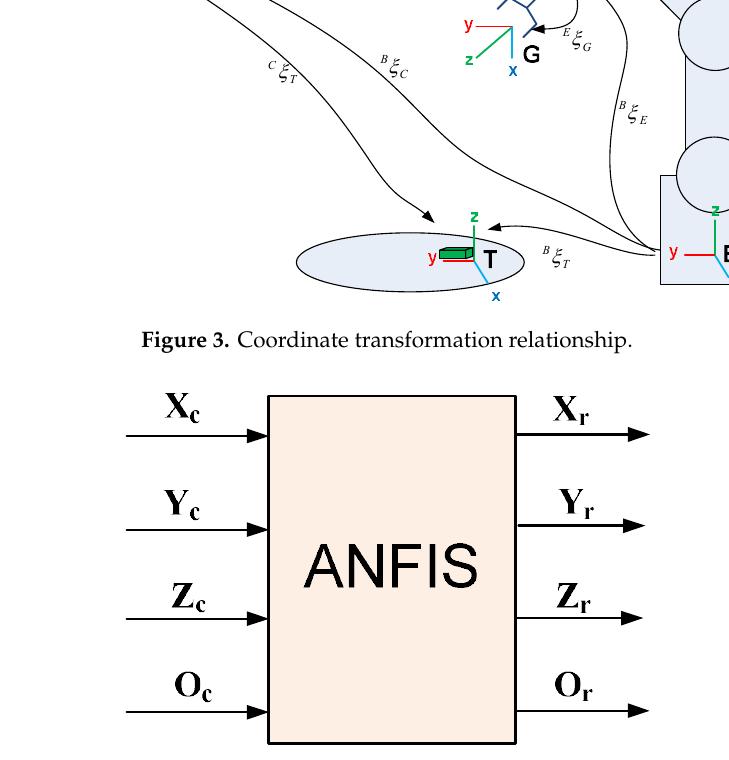
Figure 4. Block of the proposed adaptive network-based fuzzy inference system (ANFIS).